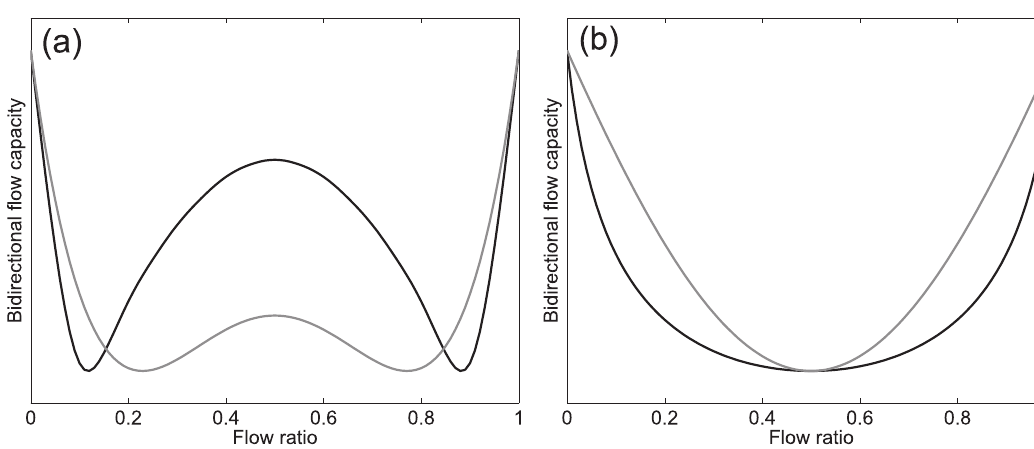
Fig 2. Typical shapes of the bidirectional capacity function. Curves presented here are only intended to support the qualitative discussion of this section, quantitative examples are provided in S1 Appendix. Typical W-shaped capacity functions are given in (a) and U-shaped curves are represented in (b).